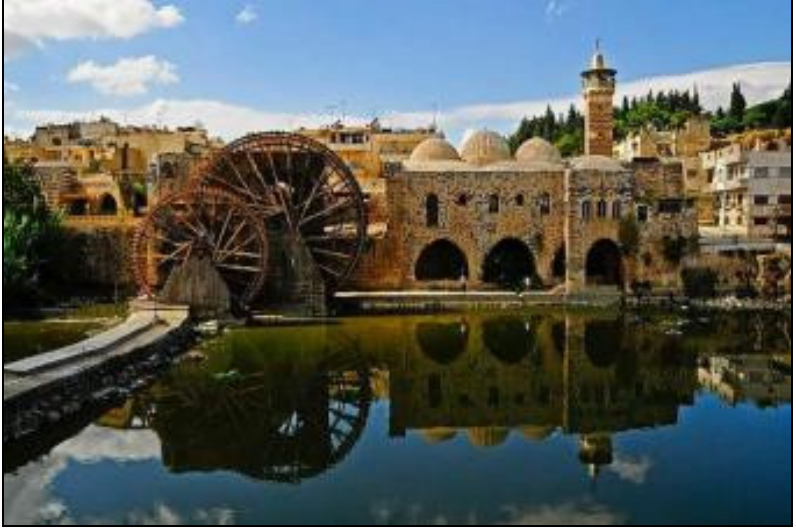
Figure 12. Nawaeer, Hama, Syria.